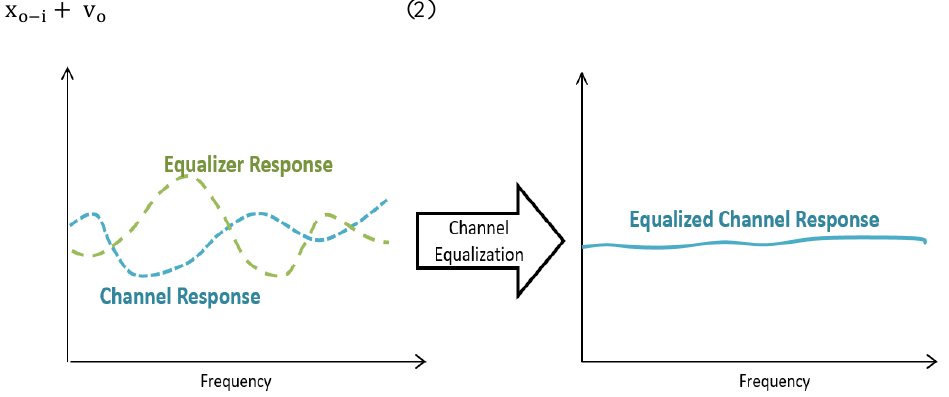
Figure 2. Channel responses after